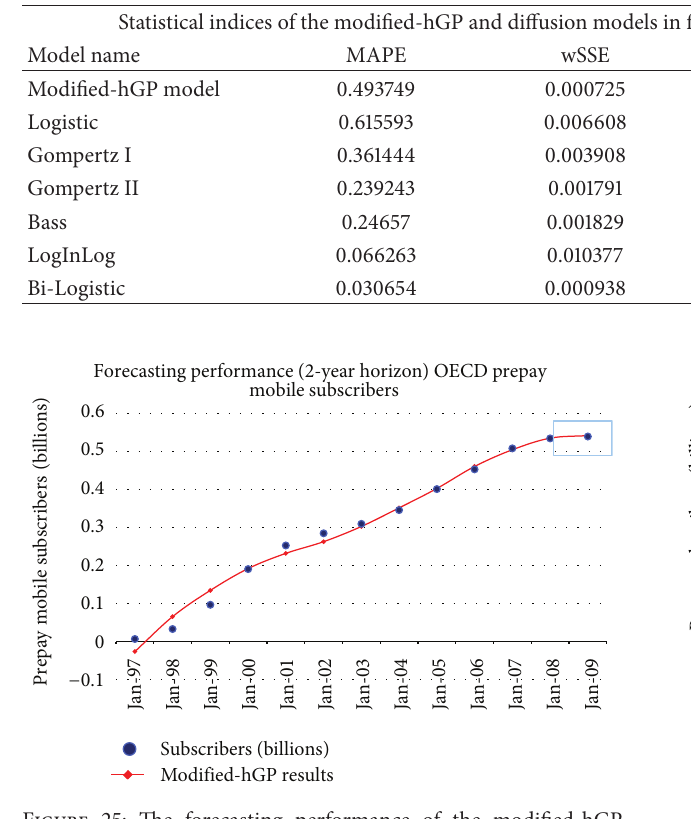
Table 9: Statistical indices in forecasting process of the modified-hGP and diffusion models for the number of OECD mobile prepay subscribers.